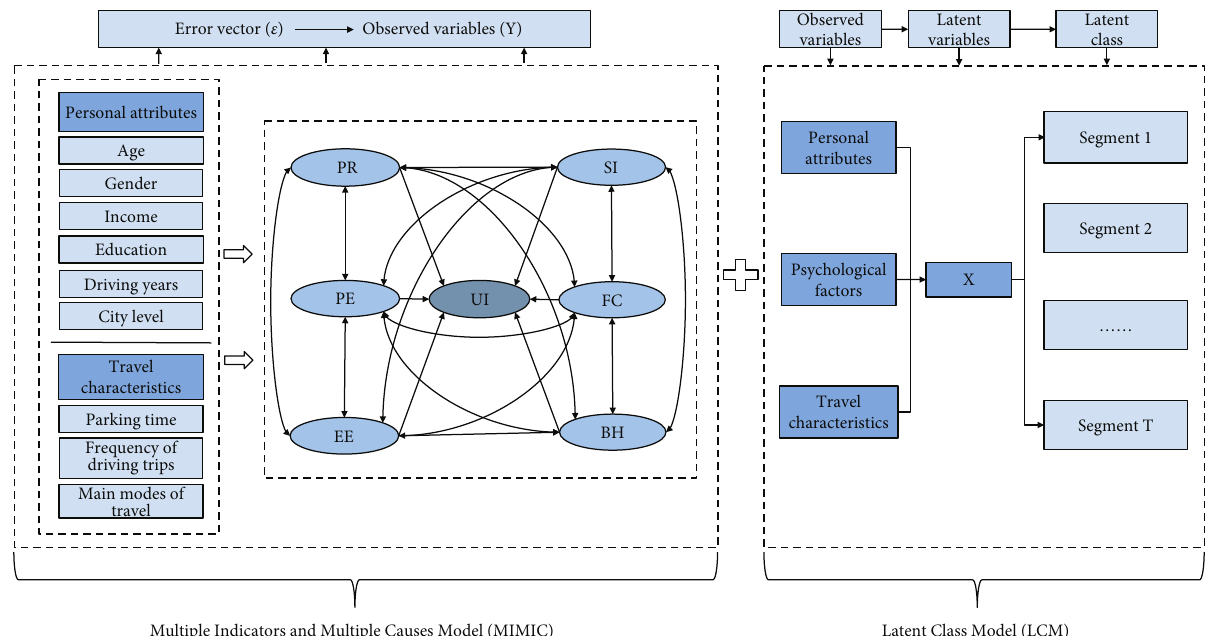
Figure 1: Modeling